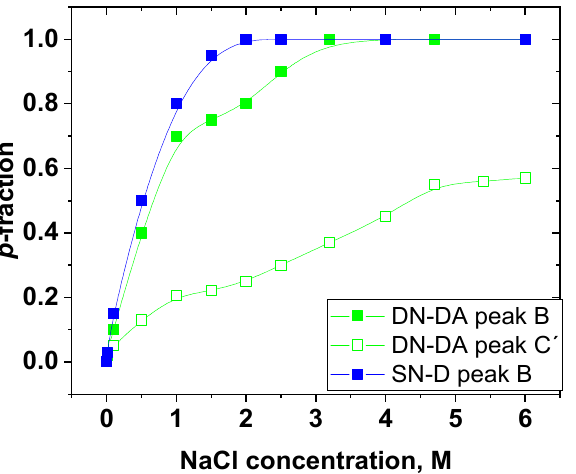
Figure 7. Dependence of the p -fraction on the NaCl concentration as determined from the PDEAAm CH 2 signal and the PAAm CH signal in the SN-D and DN-DA hydrogels at 25